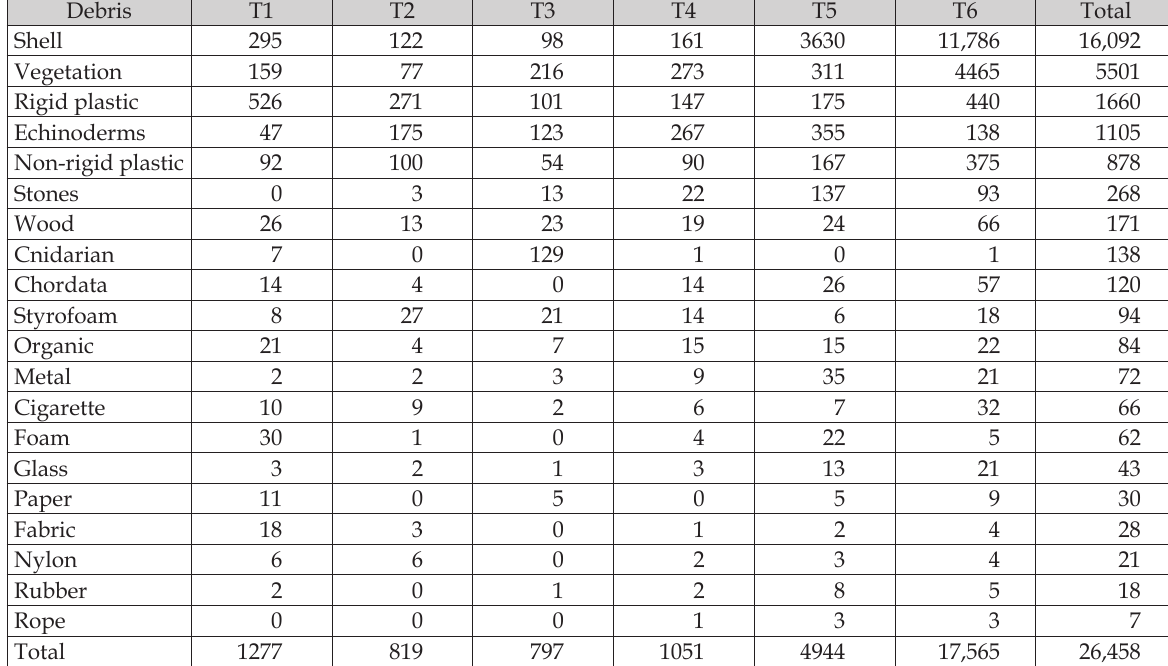
Fig. 3. Axes of the CCA for material characteristics relationships and beaching locations (season, estuary distance, width, and beach zone). CCA, canonical correspondence Table 2. Numerical amount of debris recorded in transects.